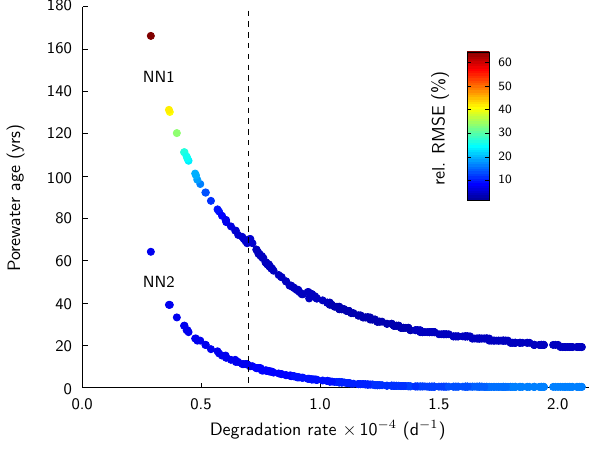
Fig. 8. Scenario B pore water age at core NN2 and NN1 in relation to the intermediate POC decay constant according to pore water sul- fate evolution. Relative root mean square errors (relative RMSE) of a particular best fit are indicated by color. Minimal relative RMSE is attained at 0.7 × 10 − 4 d − 1 (dashed